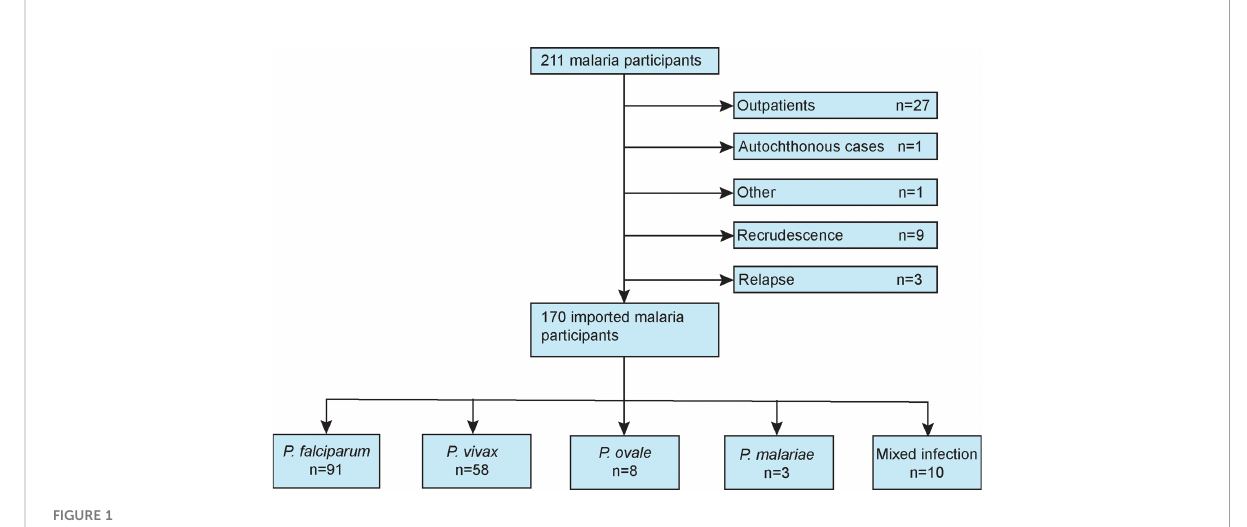
FIGURE 1 Flow diagram of the patients included in this